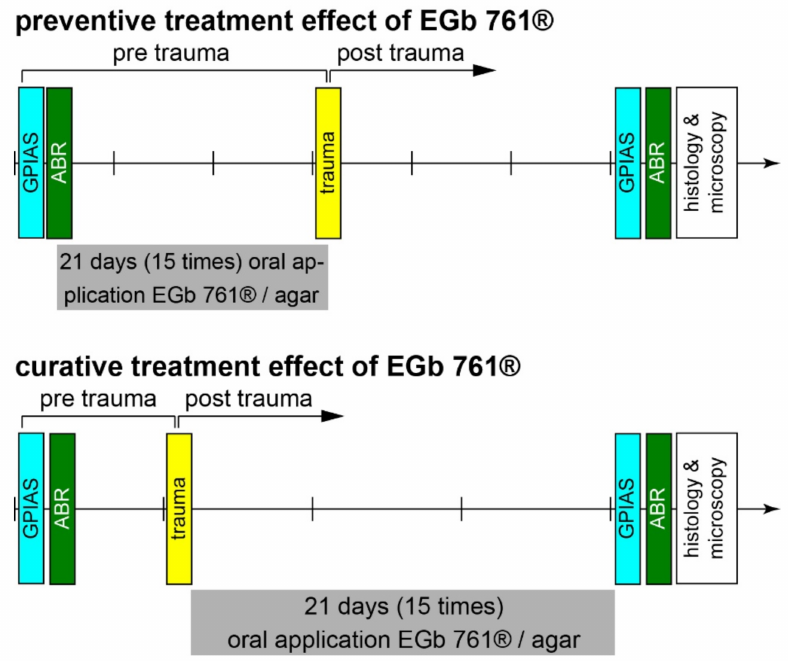
Figure 1. Time regimes of experiments for preventive treatment effects (upper panel) and curative treatment effects of EGb 761 ® (lower panel) on hearing thresholds (ABR), behavioral tinnitus assess- ment (GPIAS), and IHC ribbon synapse counts (immunohistology). The divisions on the time arrow represent 1 week